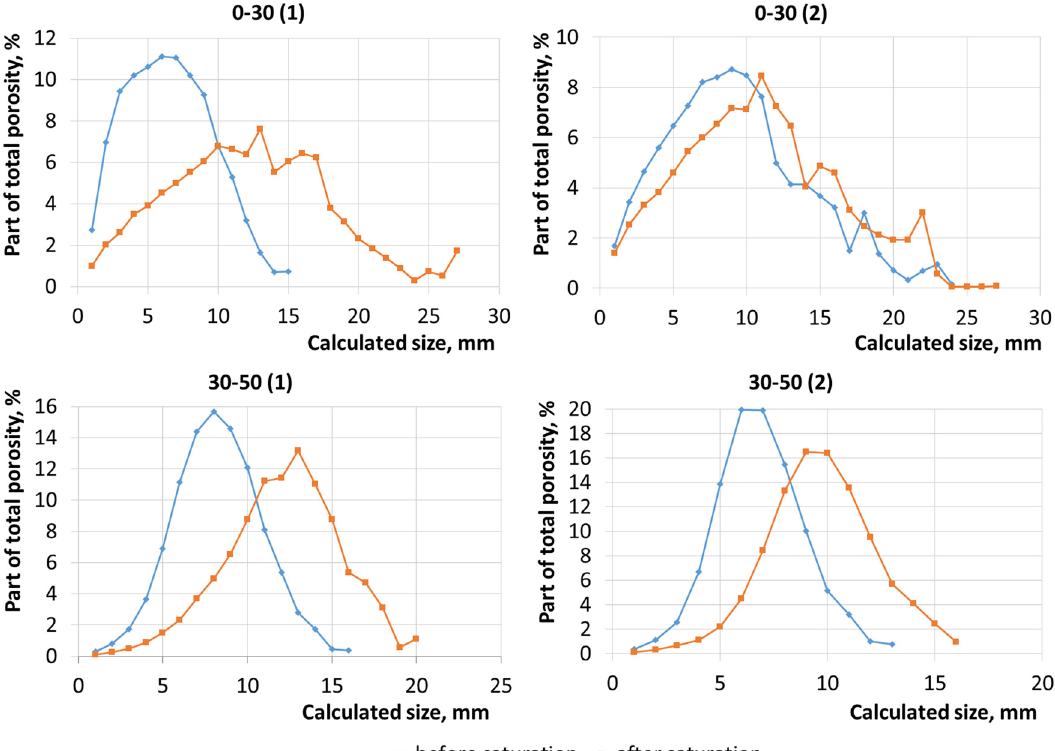
Figure 6: Macropore size distribution before and after saturation.